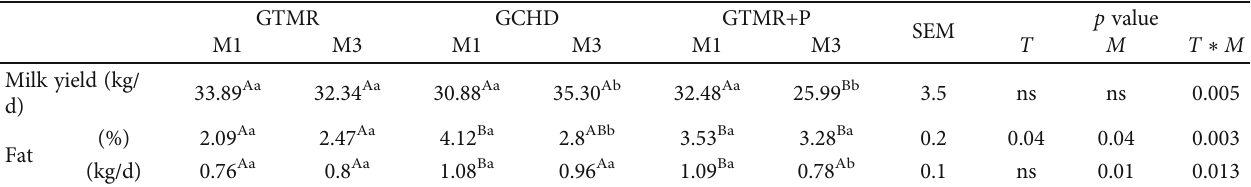
Table 2: E ff ect of treatment ( T ), month ( M ), and interaction between treatment and month ( T ∗ M ) on milk yield and fat ( mean ± SEM ) in month 1 (M1) and month 3 (M3) of lactation.